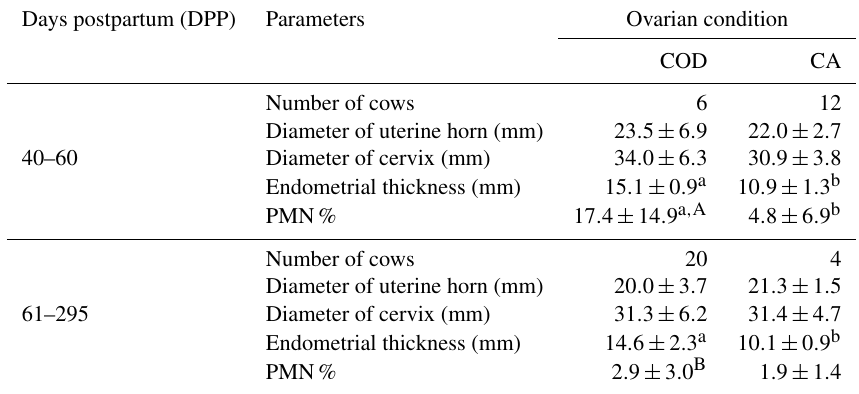
Table 2. Diameter of uterine horn and cervix measured with transrectal US and PMN% assessed with endometrial cytology in Japanese Black